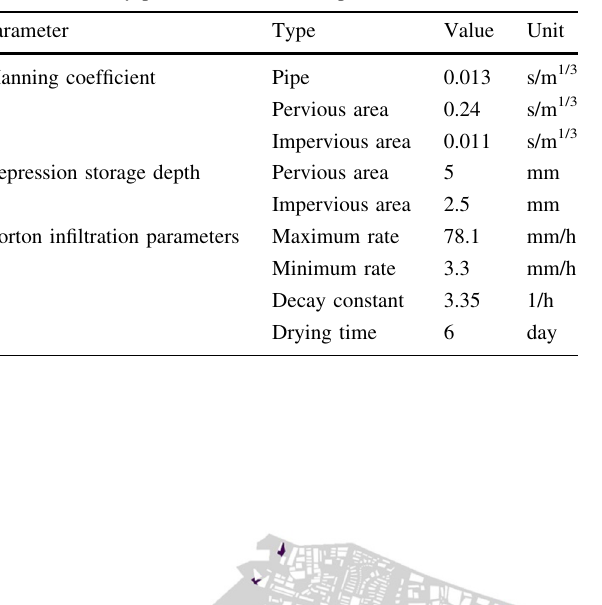
Table 1 The key parameters for the coupled model